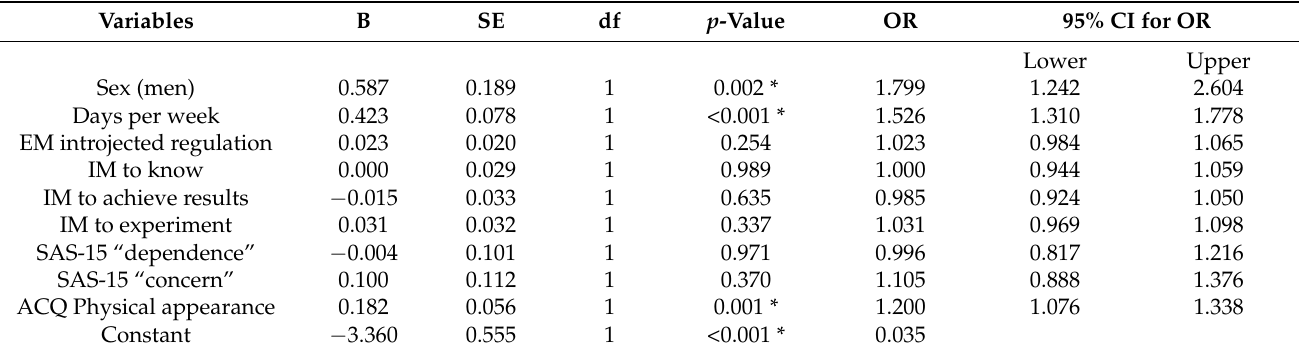
Table 6. Logistic Regression Analysis to classify the set of variables that profile